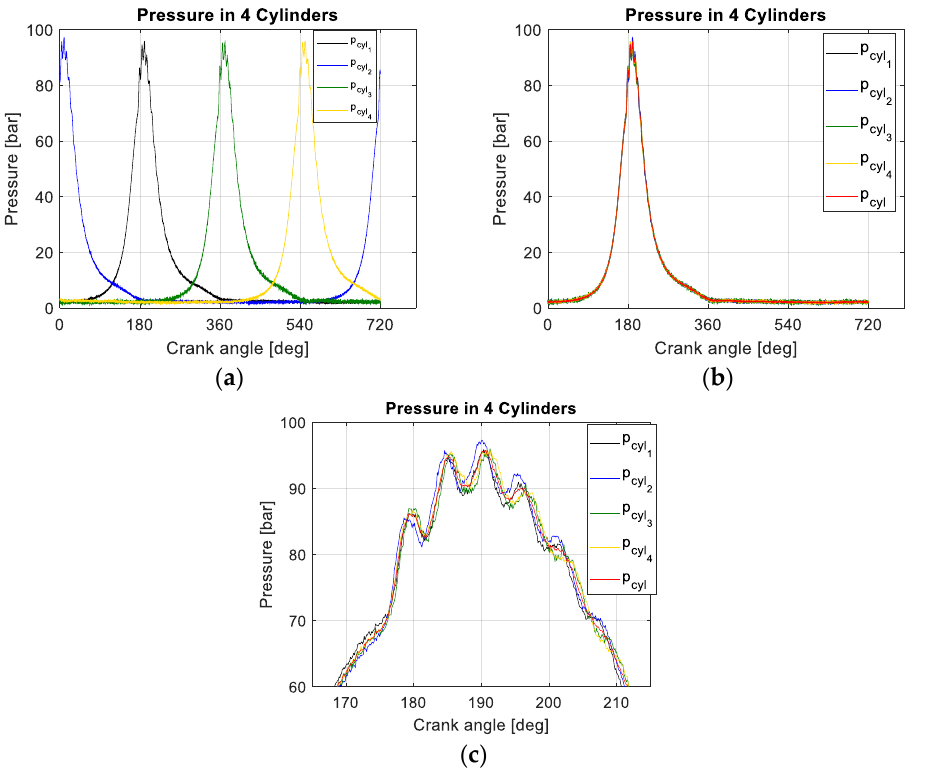
Figure 8. In-cylinder pressure of 4 cylinders: ( a ) pressure of 4 cylinders with fire order; ( b ) pressure of 4 cylinders after moving; ( c ) zoom in of peak pressure